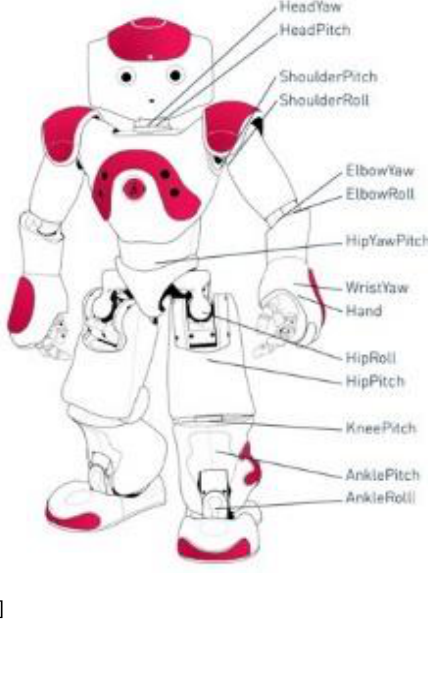
Figure 1: Active joints of NAO robot